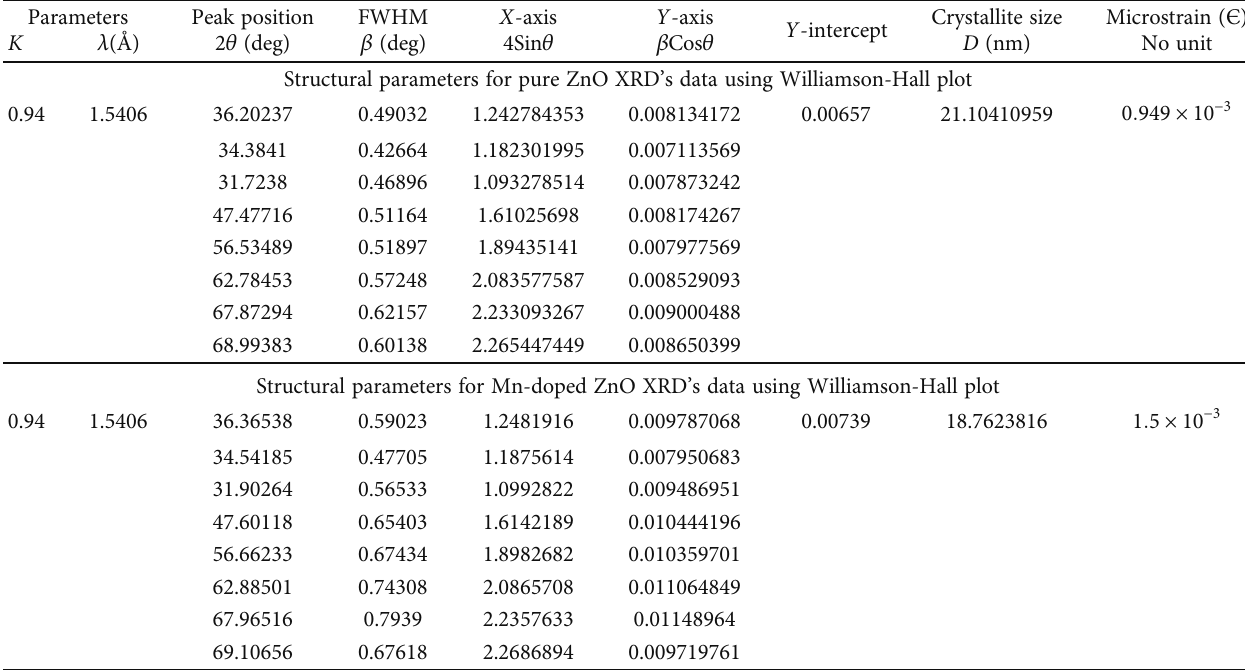
Crystallite size Microstrain ( Є ) -intercept